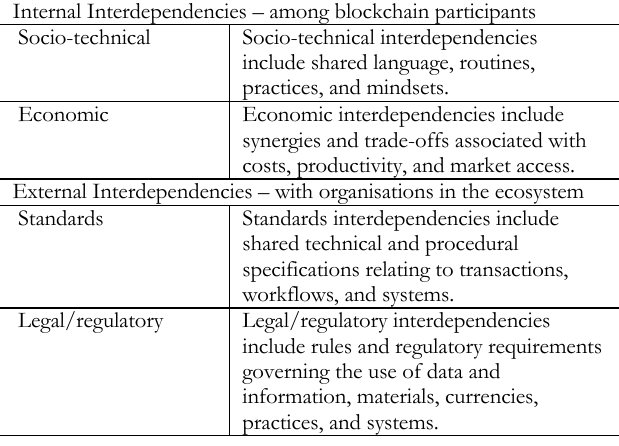
Table 2. Blockchain Interdependencies Internal Interdependencies – among blockchain participants